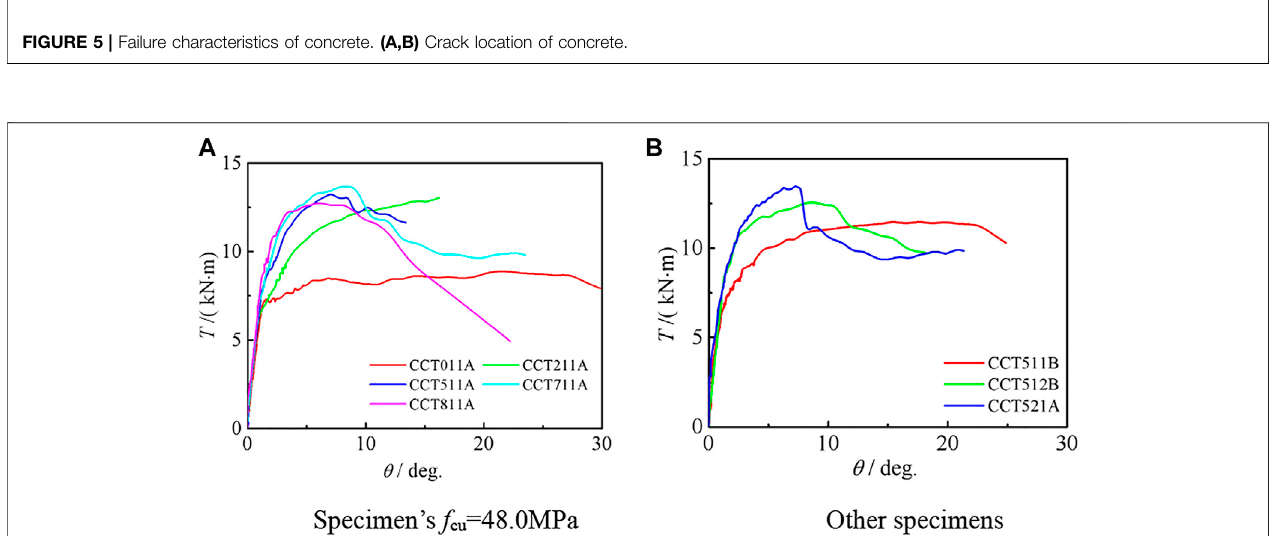
FIGURE 6 | T – θ curve of the C-CF-CFRP-ST specimen. (A,B) Different specimens.